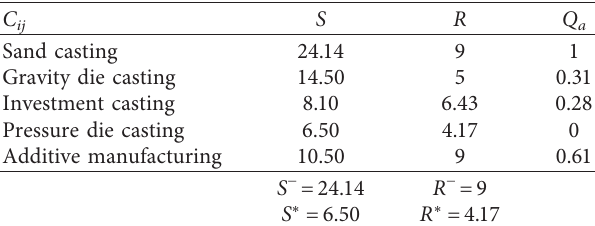
Table 12: S , R , and Q values for manufacturing processes.